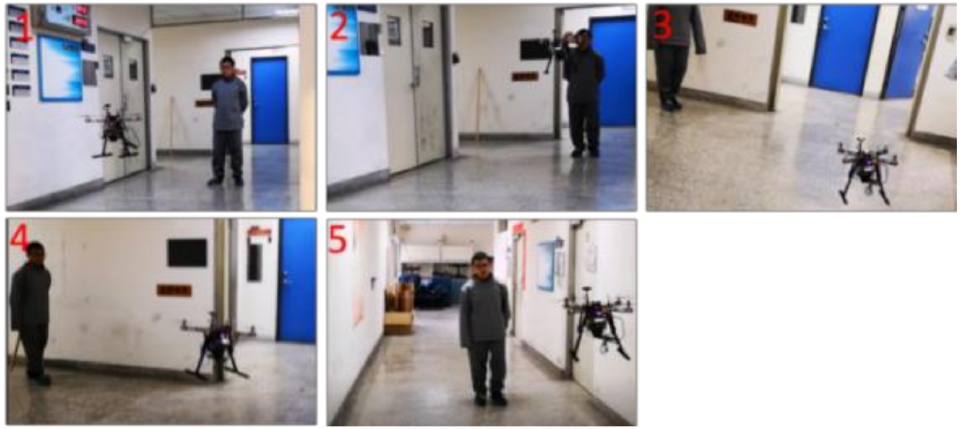
Figure 23. UAV tracking target test at the corridor (The sequence of target movement and UAV tracking is shown in 1 – 5 ).